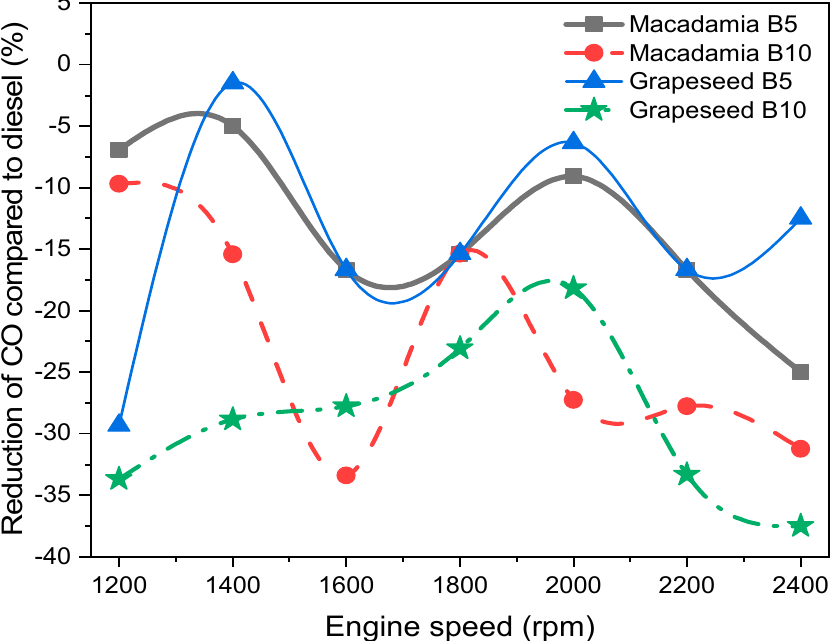
Figure 5. Reduction of carbon-mono-oxide (CO) emission using B5 and B10 biodiesel blends compared to diesel.